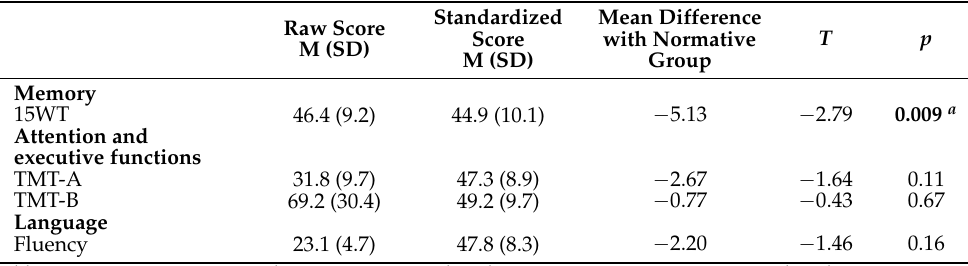
Table 4. Scores on tests for general cognition at T1 (N = 30) and comparison with normative means. Raw Score M